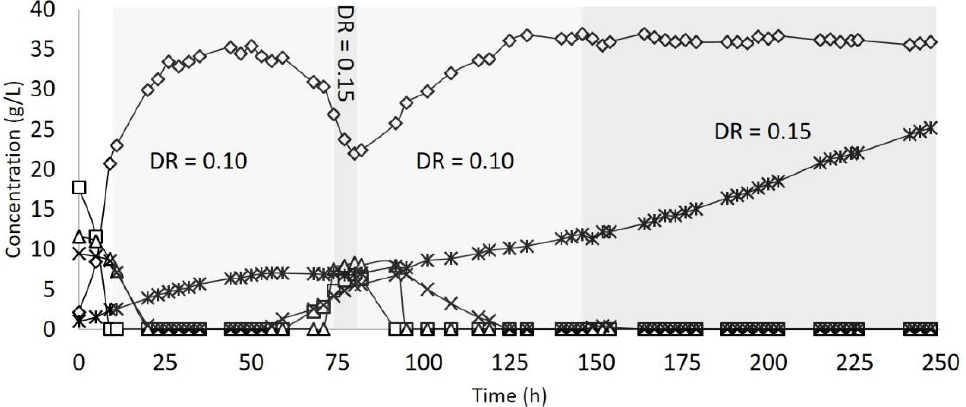
Figure 3. Continuous fermentation of SBP hydrolysate with cell retention and dilution rate (DR) variation. ( ♦ ) Lactic acid; ( (cid:3) ) Glucose; ( ∆ ) Xylose; ( × ) Arabinose; ( ∗ ) Biomass; DR = dilution rate.